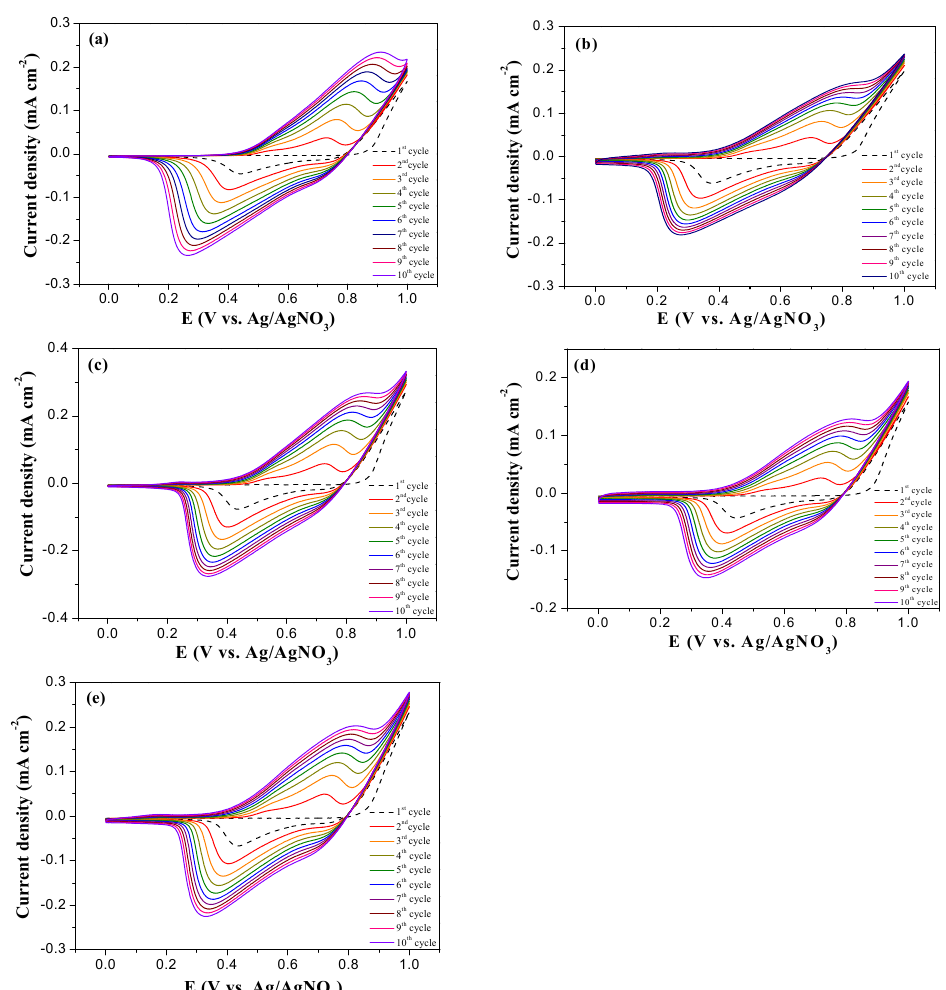
Figure 2. Electrosynthesized plots of ( a ) P(DCB), ( b ) P(DCB- co -ED), ( c ) P(2DCB- co -ED), ( d ) P(DCB- co -EDm), and ( e ) P(2DCB- co -EDm). The scan velocity is 100 mV s − 1 . The oxidized peaks of P(DCB), P(DCB- co -ED), P(2DCB- co -ED), P(DCB- co -EDm), and P(2DCB- co -EDm) were located at 0.77, 0.72, 0.74, 0.73, and 0.72 V, while the reduced peaks of P(DCB), P(DCB- co -ED), P(2DCB- co -ED), P(DCB- co -EDm), and P(2DCB- co -EDm) were